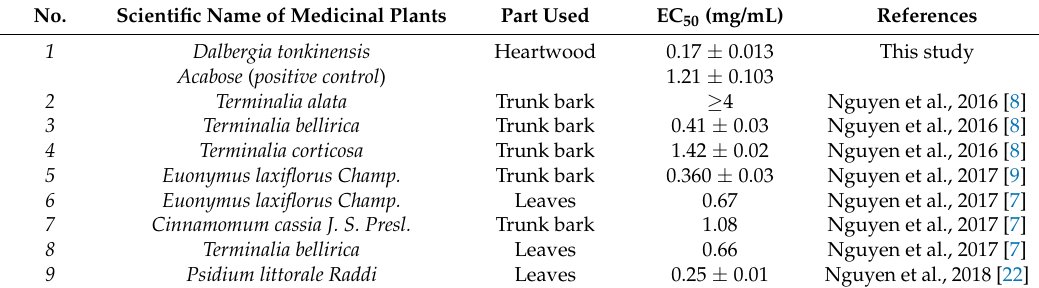
Table 1. α -glucosidase inhibition of some potential extract of medicinal plants collected in Dak Lak.